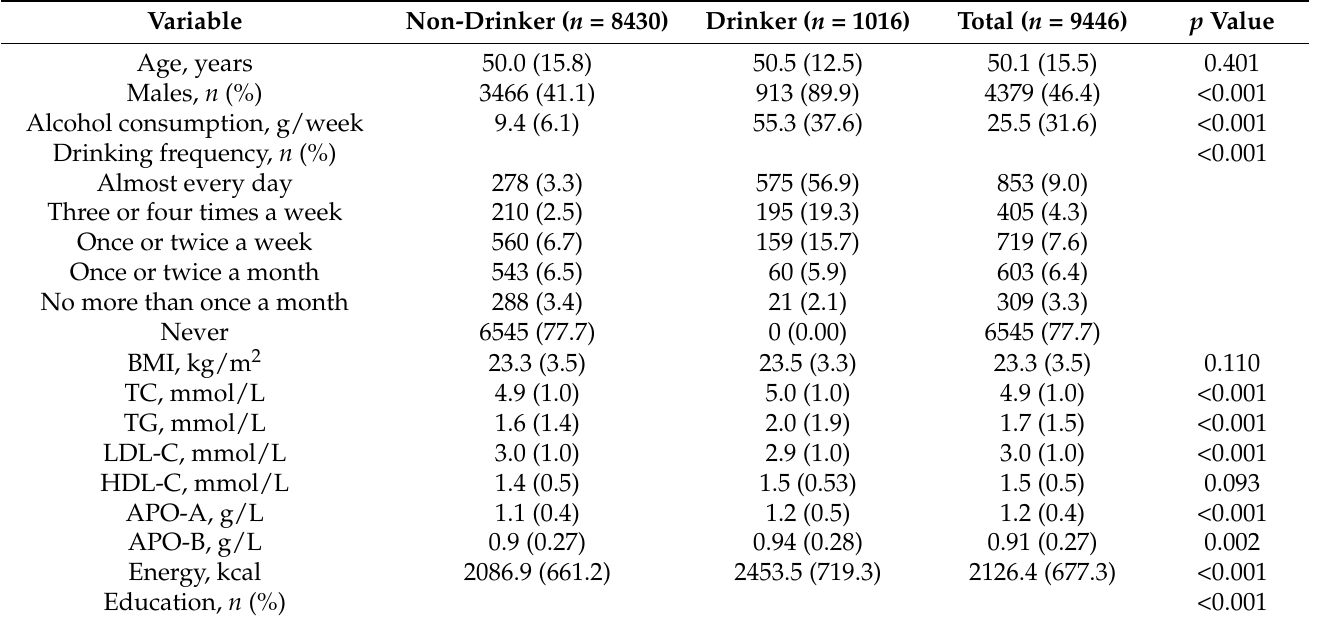
Table 1. Descriptive data of study variables by alcohol drinking.